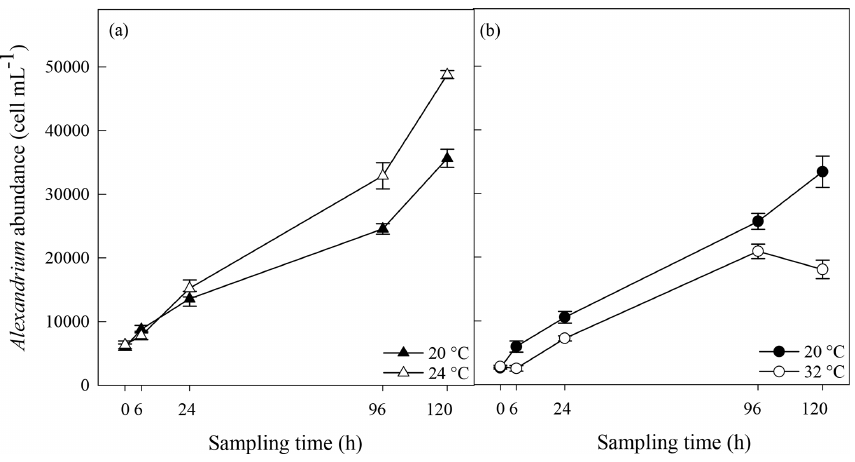
Figure 1. Algal cell abundance in A. minutum cultures in experiment 1 (20 and 24 ◦ C) (a) and experiment 2 (20 ◦ C and 32 ◦ C) (b) ; aver- age ± SE, n = 4.